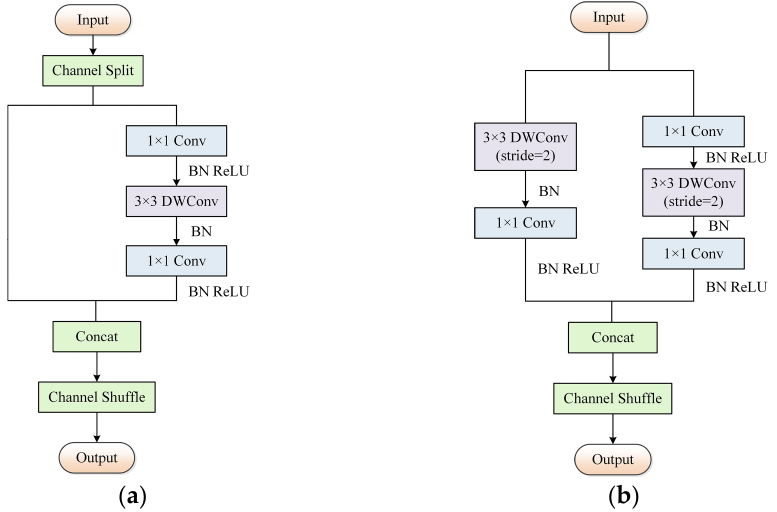
Figure 5. Building blocks of Shu ffl eNetV2: ( a ) basic unit; ( b ) downsampling unit.